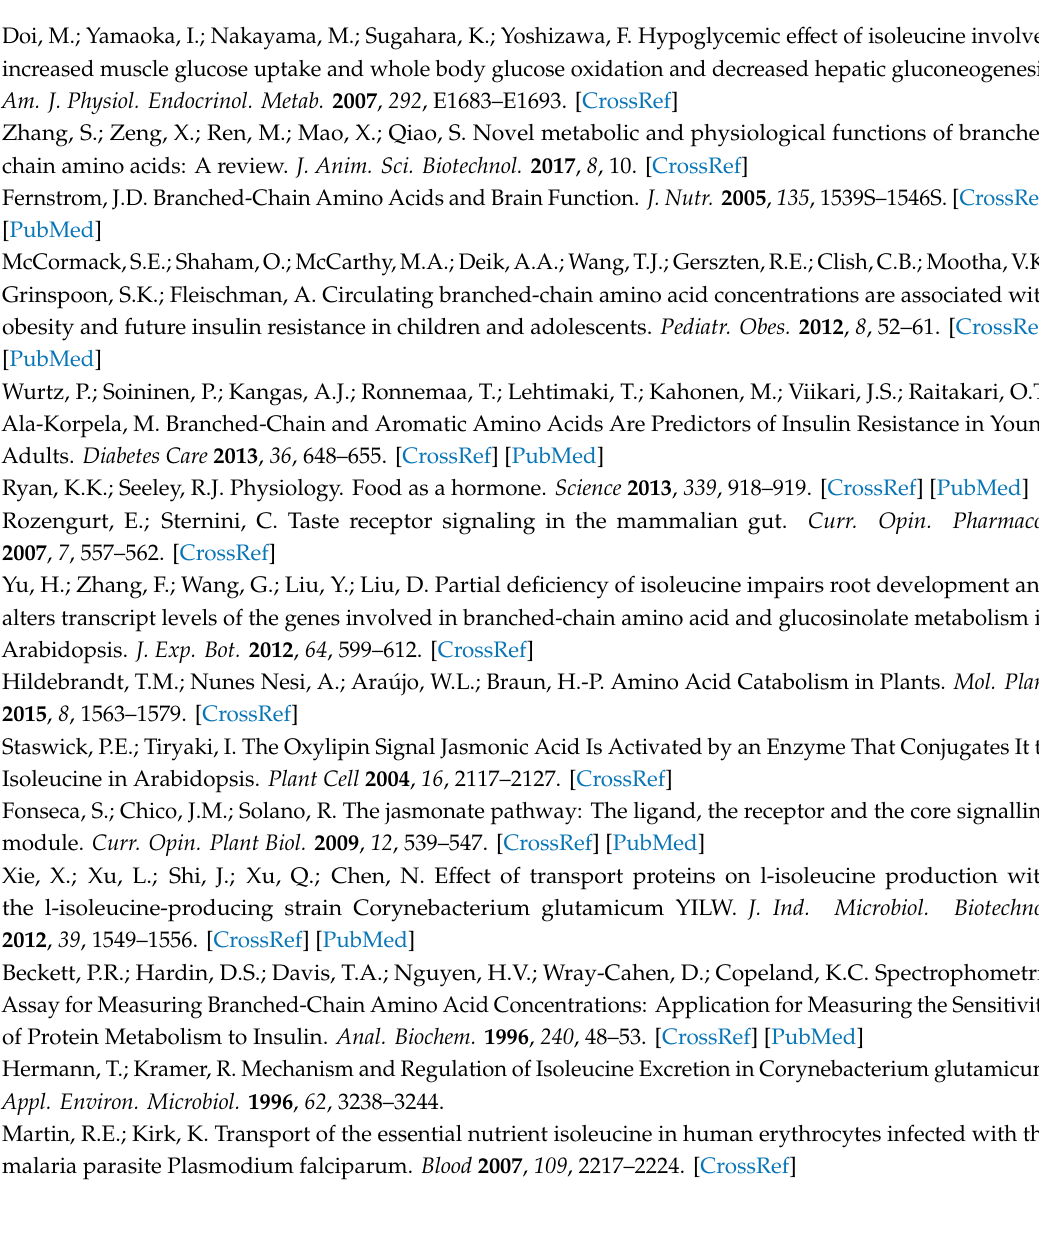
Table S2: Raw results for the titration experiments with GEII and its mutants, Table S3: In silico mutations in LivJ protein from polar to non-polar residues and vice-versa, Video S1: Live-monitoring of isoleucine uptake in yeast